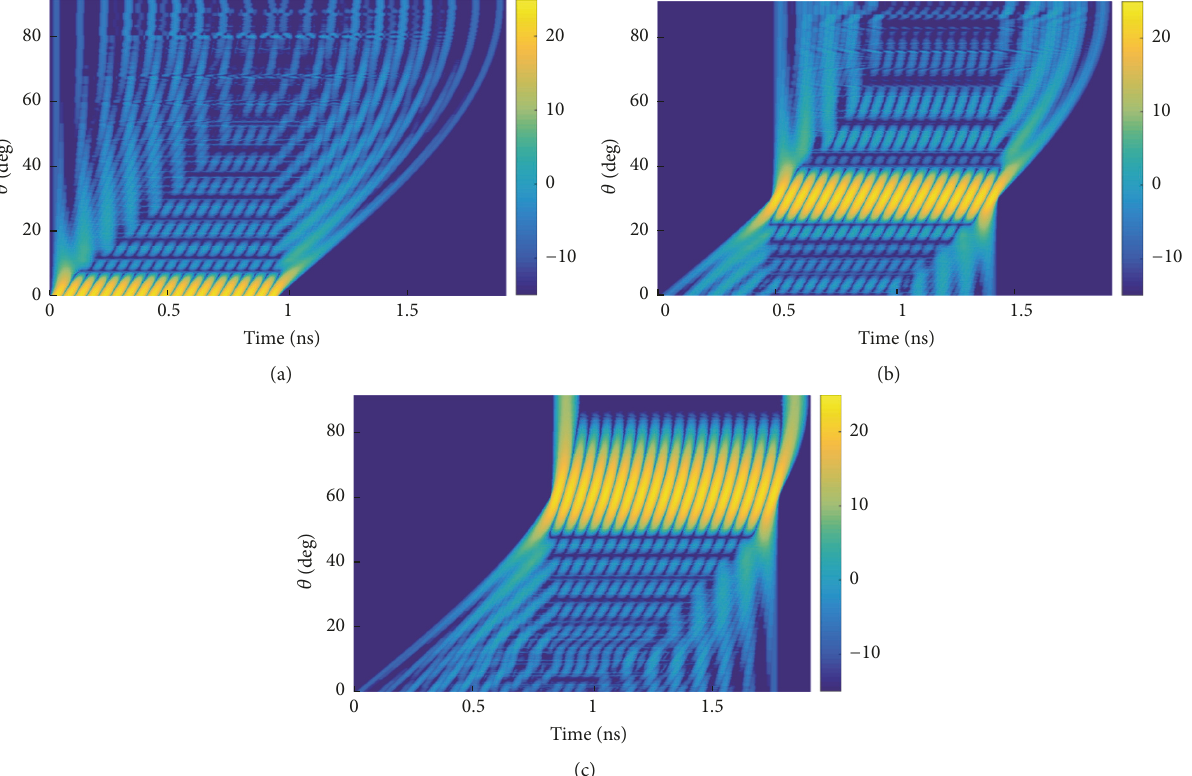
Figure 10: Pulse dispersion in a 20-element linear timed array as a function of angle when the angle of incidence equals the scan